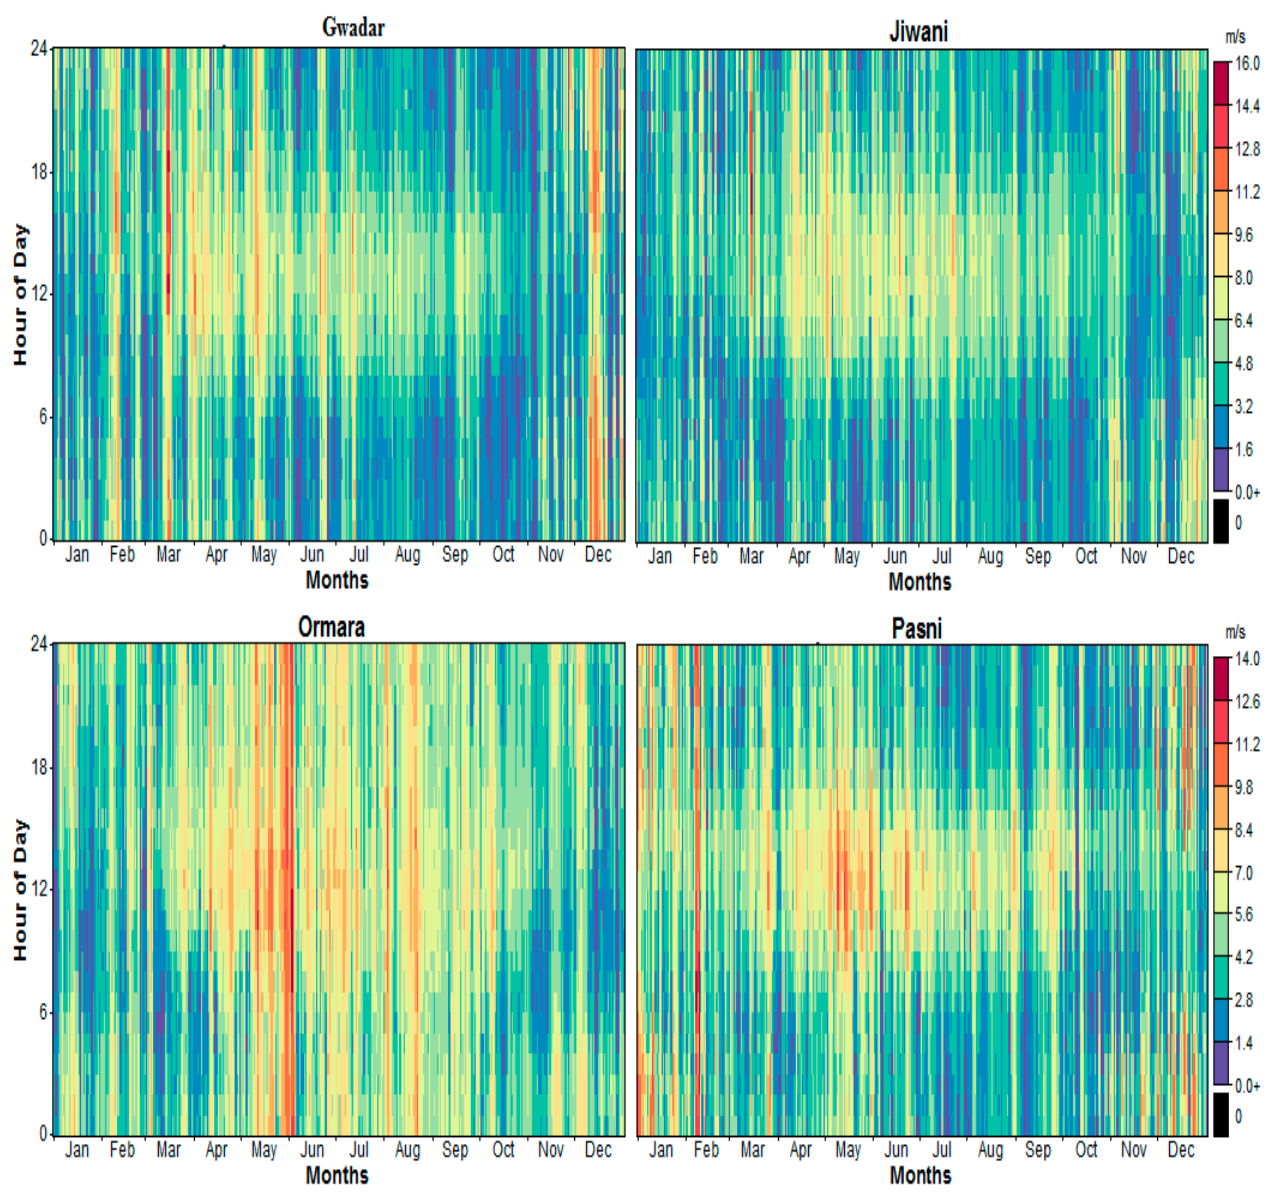
Figure 4. Monthly and daily representation of WS data from all regions [34].